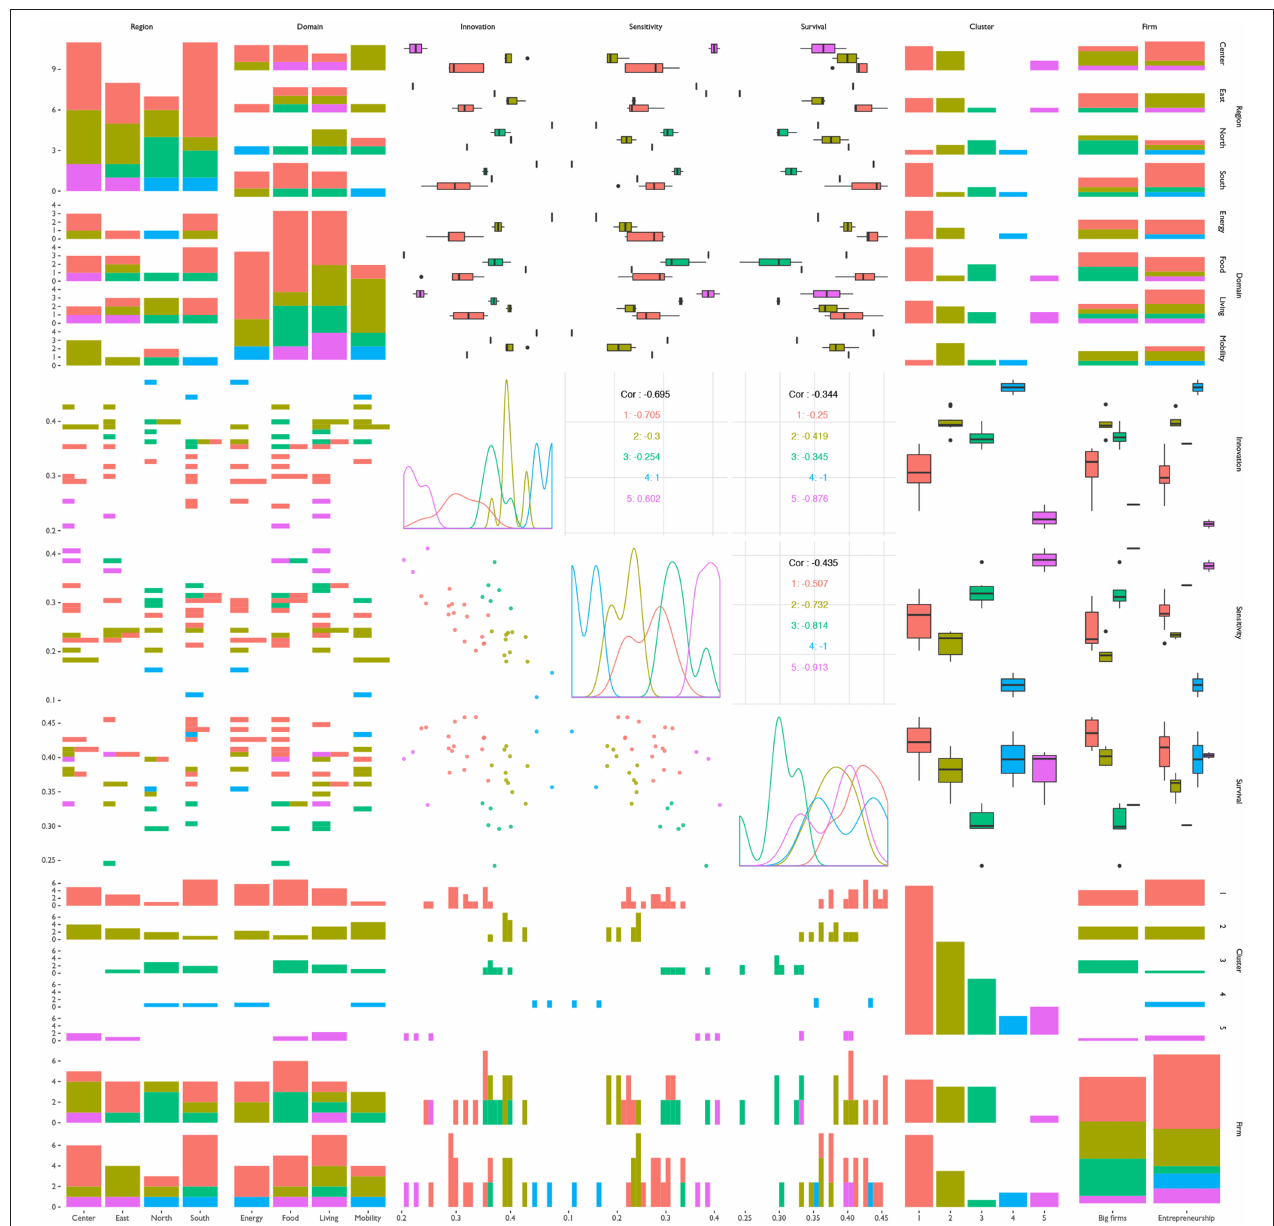
FIGURE 12 | Pair plot between the variables that identify the cases (Country, Domain, WP), the variables that define the clusters (Innovation, Sensitivity, and Survival) and the identification of clusters (Cluster). The figure allows to understand the characteristics of every of the clusters involved. The diagonal of the matrix of plots contains the descriptive representations of the variables (for instance, boxplots for a categorical variable, and density plots for continuous ones). And the off-diagonal plots represent the bivariate associations (scatterplots in the three continuous/continuous variables, boxplots in the continuous/categorical and barplots in the